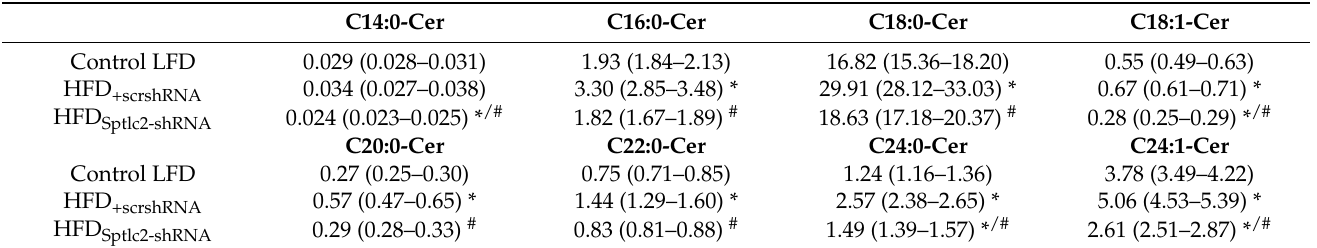
Table 2. The Impact of Sptlc2 Silencing on the Content of Ceramide in the Mouse Gastrocnemius Muscle.